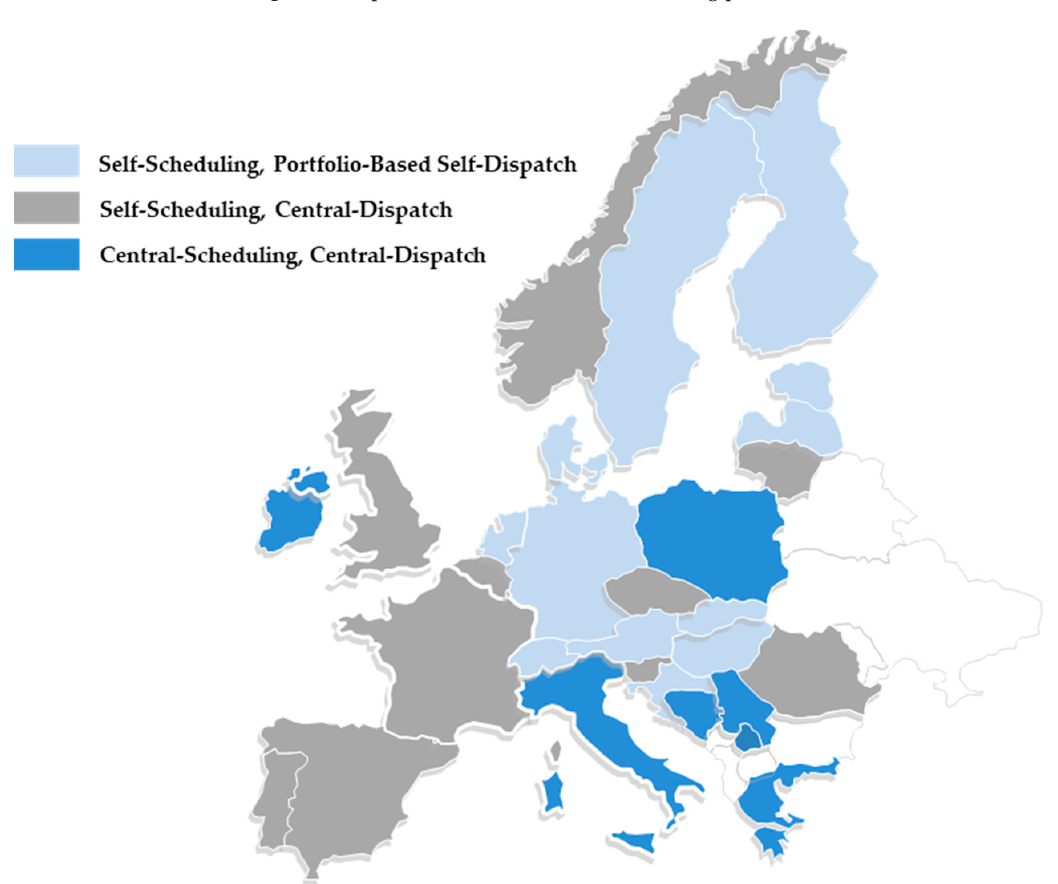
Figure 2. Balancing arrangements in the European countries (source [34]).